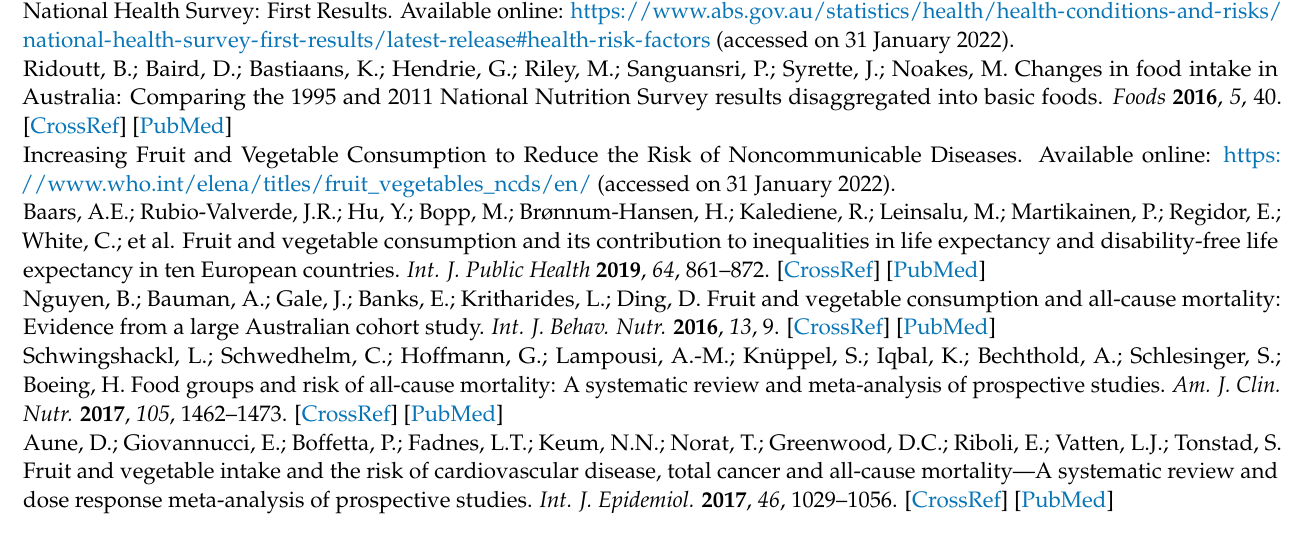
the environmental impact score, Table S2: Sample size for the higher diet quality and lower en- vironmental impact (HQLI) subgroup according to age group and gender, Table S3: Food intake (servings/person/day) for the HQLI subgroup of adult diets, Table S4: HQLI subgroup of Australian adult daily diets: variety scores for vegetable